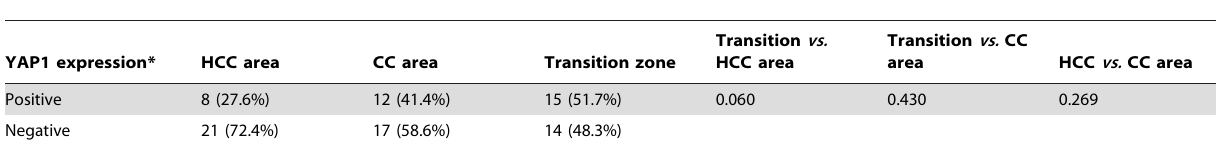
Table 2. YAP1 expression in each histologic component of combined hepatocellular-cholangiocarcinomas (classic type).